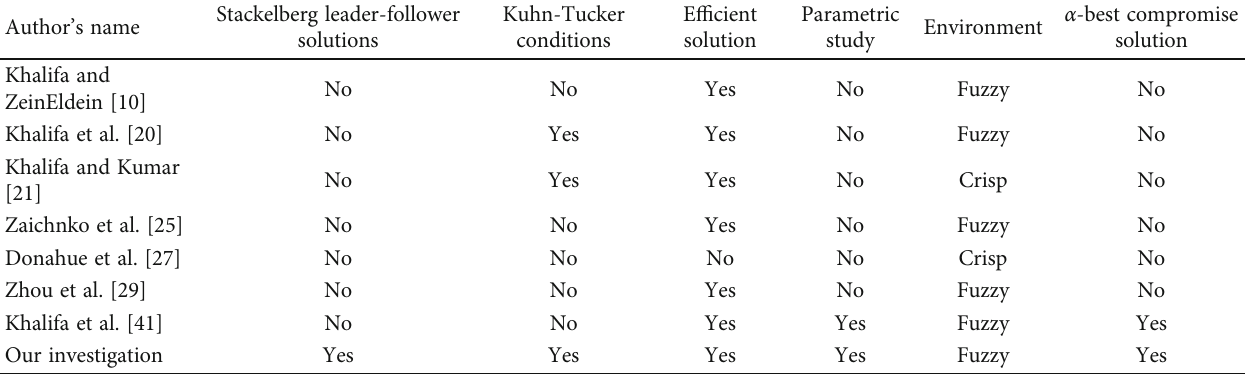
Table 1: Comparisons among the proposed and existing